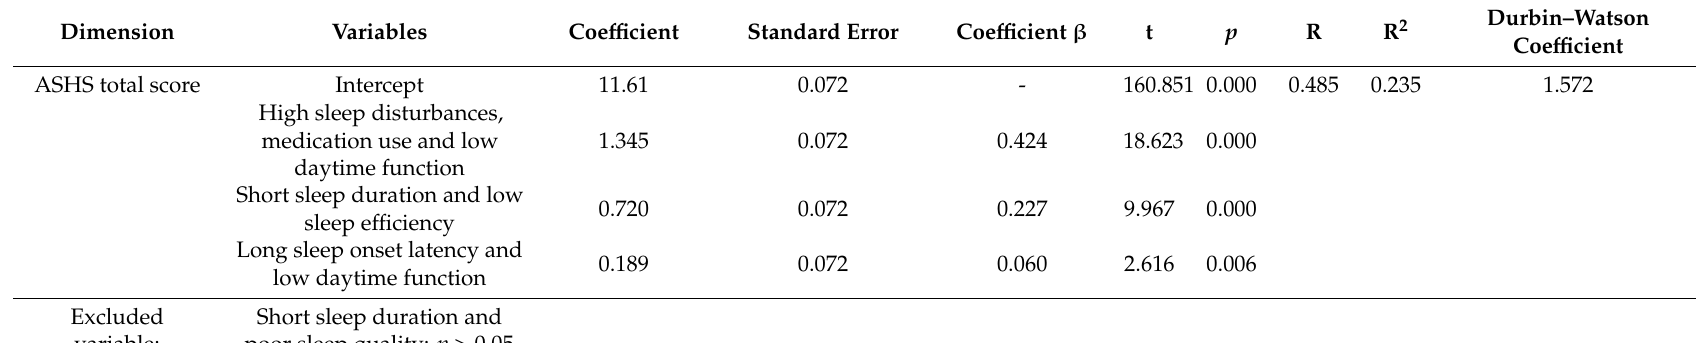
Table 6. Multiple linear regression with the new factors of the Pittsburgh Sleep Quality Index as predictors and the Adolescent Sleep Hygiene Scale (overall score) as dependent